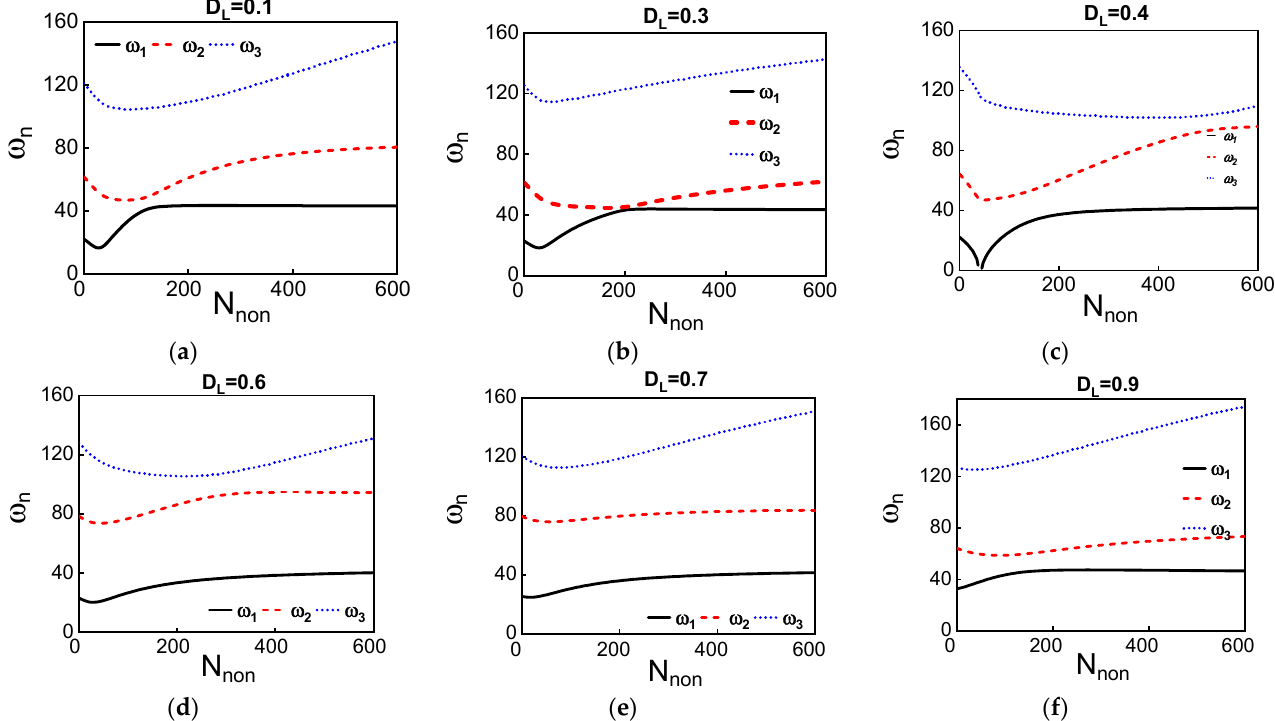
Figure A2. ( a – f ): The variation of the three lowest natural frequencies with axial load for different dome lengths. The initial rise of the dome is equal to 2 μ m.